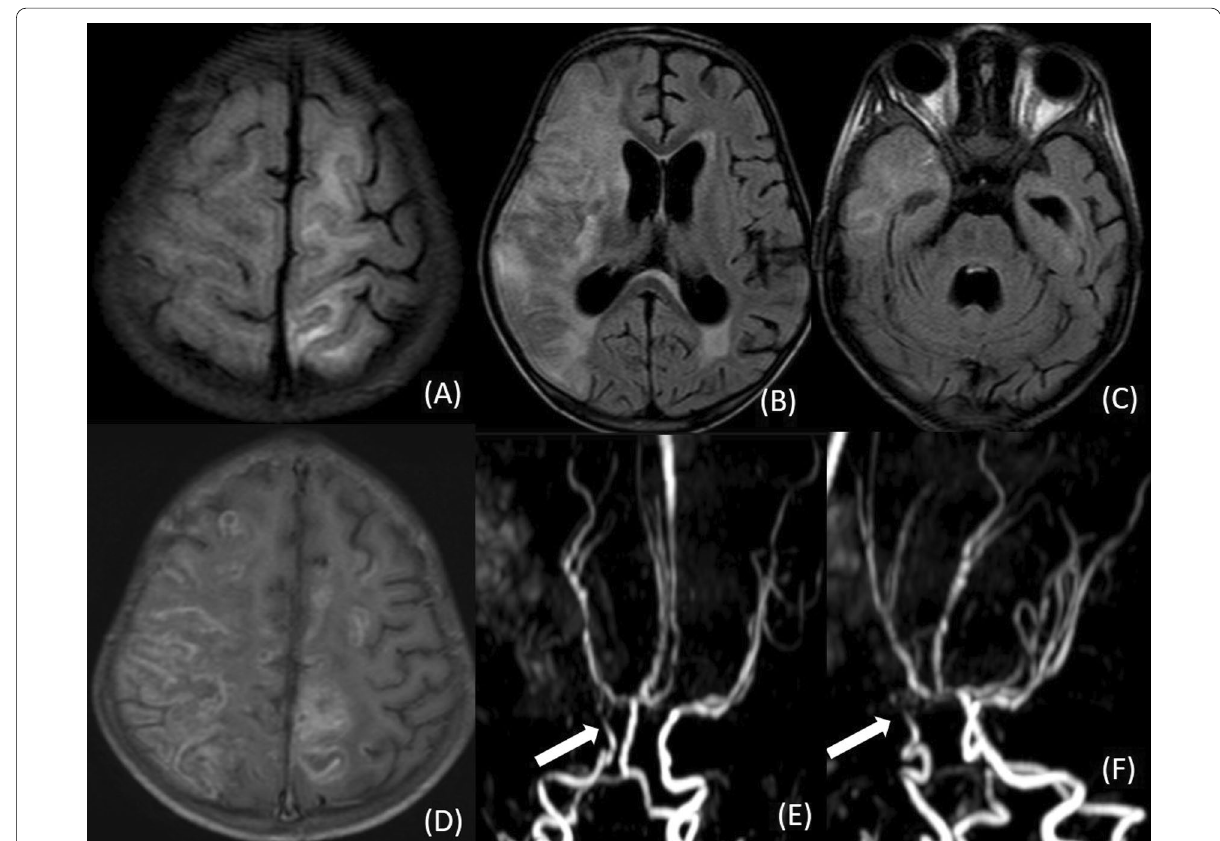
Fig. 3 CNS TB with moyamoya vasculopathy. MRI of a 4-year-old boy shows hyperintensity involving both grey and white matter in bilateral ACA and right MCA territory on FLAIR images ( A – C ), T1 contrast-enhanced image shows leptomeningeal enhancement in bilateral ACA territory- ivy sign ( D ). MR angiography ( E , F ) shows near-complete occlusion of supraclinoid segment of right ICA and attenuation of supraclinoid segment of left